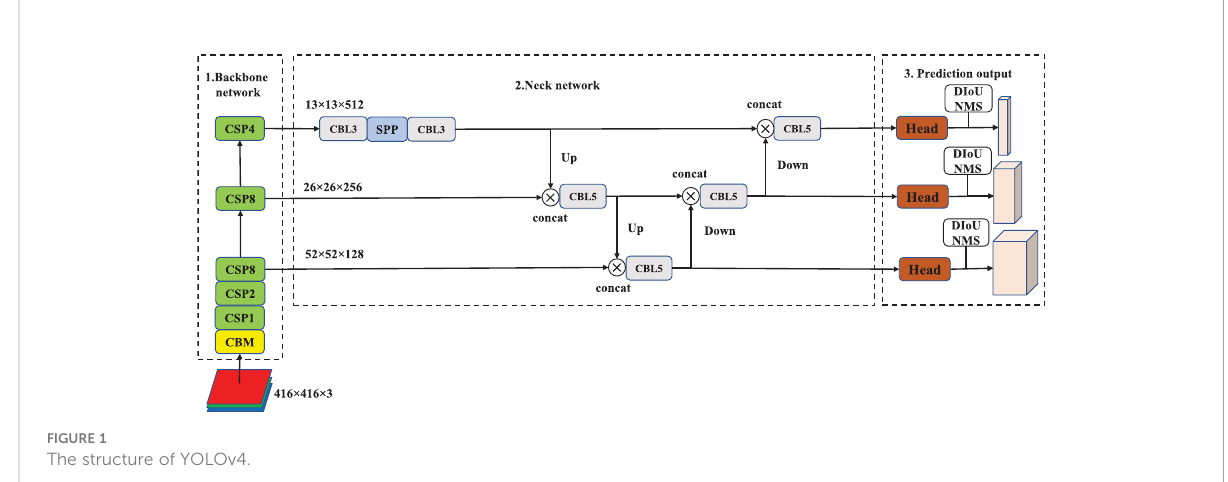
FIGURE 1 The structure of